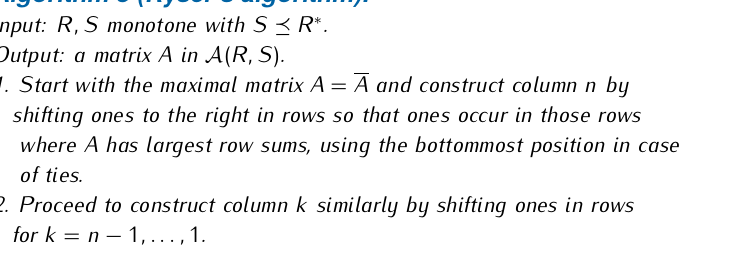
Algorithm 8 (Ryser’s